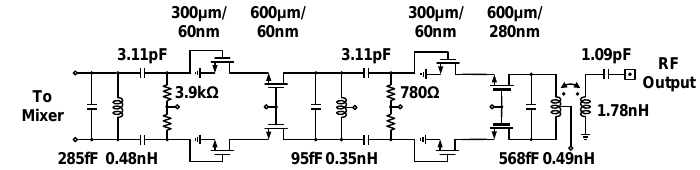
Figure 5. Circuit schematic of the class-AB power